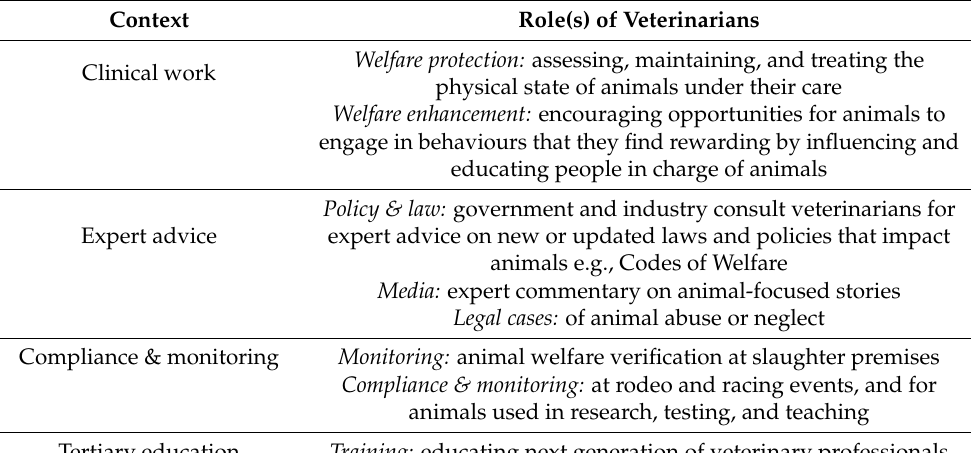
Table 1. The range of contexts in which veterinarians are ideally placed to advance animal welfare and examples of the roles they do or could play in each context. Welfare protection refers to preventing or alleviating negative states; Welfare enhancement refers to promoting positive